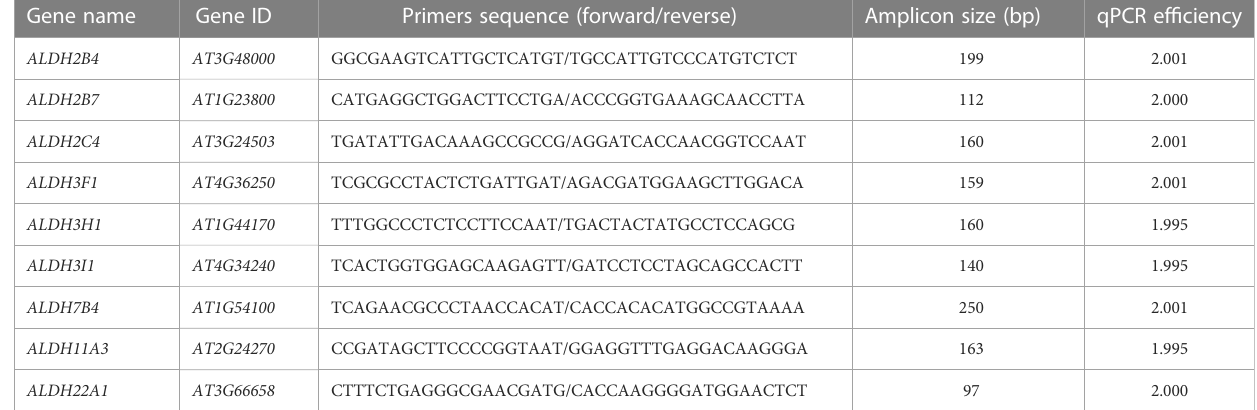
TABLE 1 Nucleotide sequence, amplicon size and qPCR ef fi ciency of the oligonucleotide primers designed for this